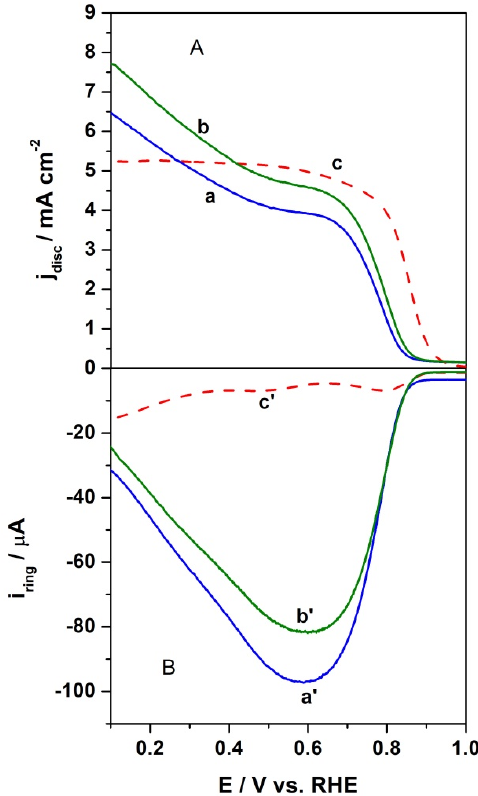
Figure 8. RRDE polarization curves (background subtracted) for oxygen reduction at CFeN@rGO- COOH (a) in the absence of external magnetic field (blue curve) and (b) in the presence of external magnetic field (green curve), and (c) Pt/C nanoparticles (red curve). ( A ) Disk currents and ( B ) ring currents. Electrolyte: O 2 -saturated 0.1 mol dm − 3 KOH. Scan rate: 10 mV s − 1 . Rotation rate: 1600 rpm. Ring currents are obtained upon application of 1.21 V.